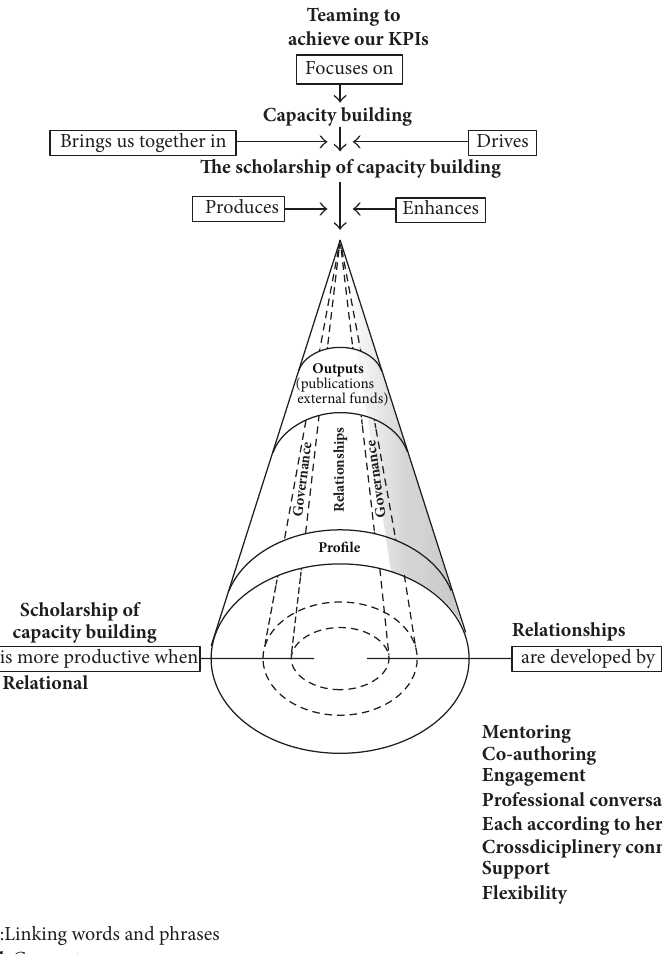
Figure 2: The second collaborative concept map produced by the research